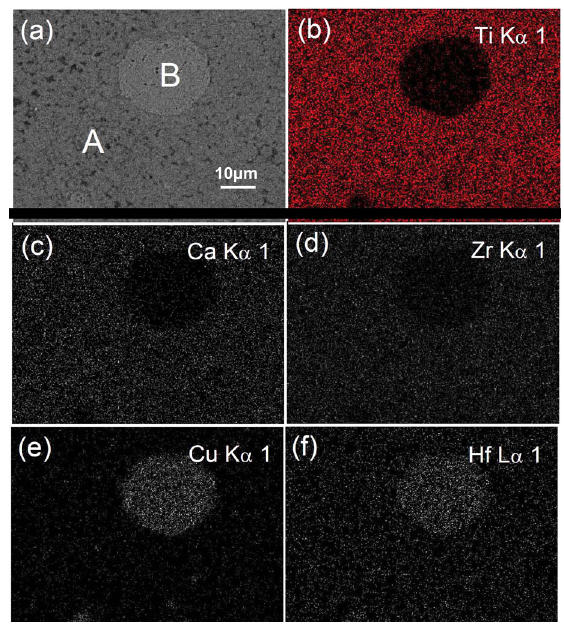
Fig. 6 SEM–EDX mapping images of the Cu-Hf-0.6 sample: (a) representative BSE image, (b)–(f) elemental distribution of Ti, Ca, Zr, Cu, and Hf elements.